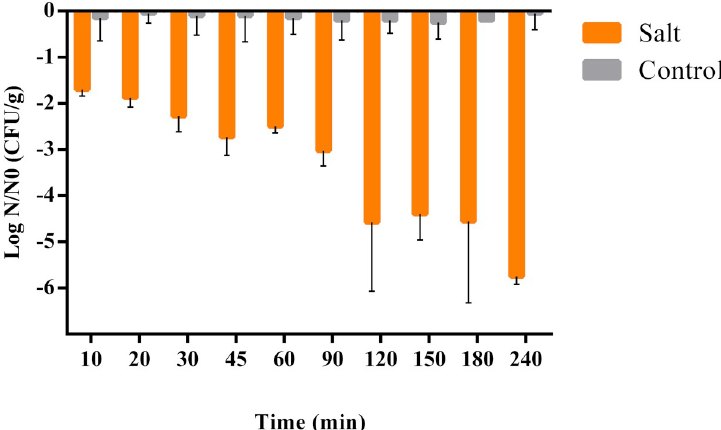
Fig 3. Survival of Campylobacter spp. in cooking salt. Results are presented as survival/difference from the control is the bacterial number in the controls at time zero, and N i s the bacterial number calculated as Log (N/N 0 ) (where N 0 at different times after inoculation). Columns present mean and standard deviation of four independent